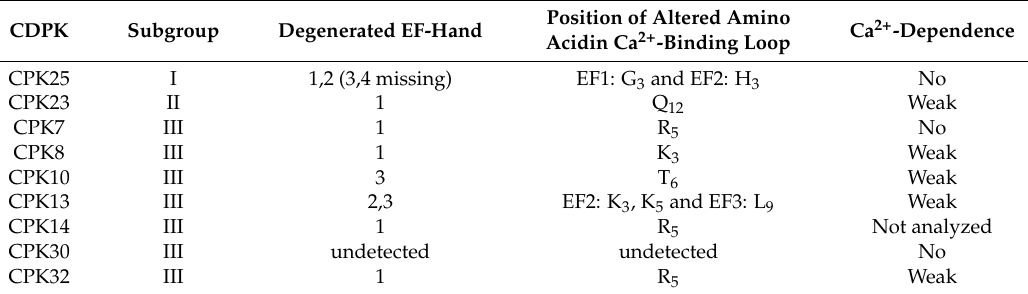
Table 2. Degenerated EF-hand motifs of